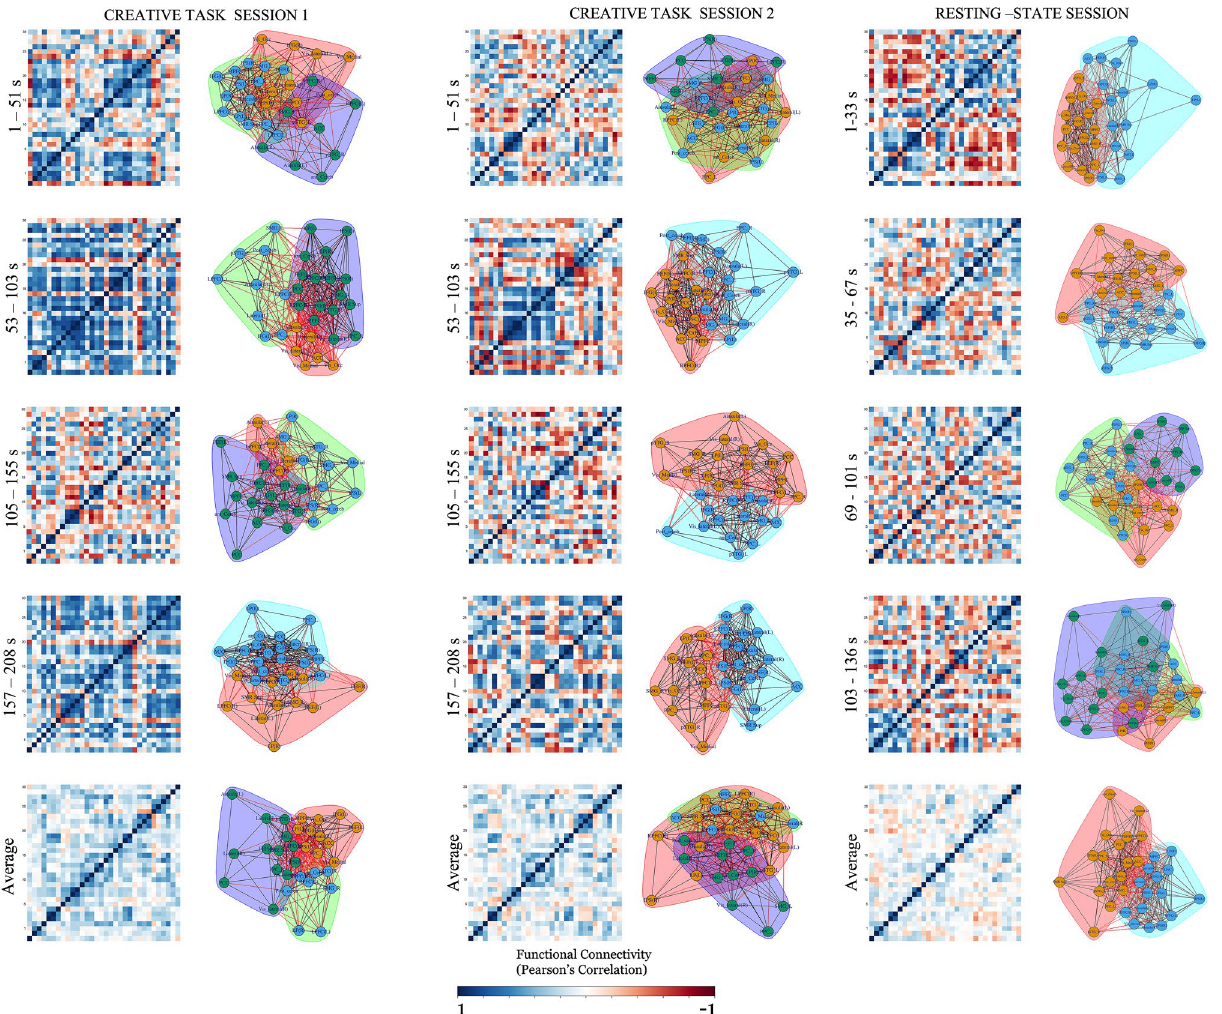
Figure 3. Region-specific changes across time using sliding-window approach (window size = 44 s) for creative task session 1, creative task session 2 and resting-state session. The first column in each session indicates the single windowed correlation map between these times. The bottom row indicates the average of all the first four rows across all the sessions. Second column in every session indicates the graph representation and community detection formed using the fast-greedy algorithm community detection. Each colour indicates community formation for every session, averaged and every windowed correlation map. Node Label List: mPFC medial pre- frontal cortex, LP_L parietal left (lateral), LP_R parietal right (lateral), PCC posterior cingulate cortex, SMR_L sensorimotor cortex left, SMR_R sensorimotor cortex right, SMR_Superior sensorimotor cortex (superior), Visual_Medial visual cortex (medial), Visual_Occipital visual cortex (occipital), Visual_lateral_L visual cortex left (lateral), Visual_lateral_R visual cortex right (lateral), ACC Anterior cingulate cortex, AInsula_L anterior Insula left, AInsula_R anterior Insula right, rPFC_L pre-frontal cortex left (rostral), rPFC_R pre-frontal cortex right (rostral), SMG_L supramarginal gyrus left, SMG_R supramarginal gyrus right, FEF_L frontal eye fields left, FEF_R frontal eye fields right, IPS_L intra-parietal sulcus left, IPS_R intra-parietal sulcus right, LPFC_L pre-frontal cortex left (lateral), PPC_L parietal cortex left (posterior), LPFC_R pre-frontal cortex right (lateral), PPC_R parietal cortex right(posterior), IFG_L inferior frontal gyrus left, IFG_R inferior frontal gyrus right, pSTG_L superior temporal gyrus left, pSTG_R superior temporal gyrus right, Cereb_Ant anterior cerebellum, Cereb_Post posterior gyrus and left superior temporal gyrus. The respective correlation matrices and the networks formed have been depicted in row 2 of Fig. 3 for all the three sessions. For the third averaged window, during the task session 1 (i.e. time 105–155 s), the regions of the DMN showed connections with the bilateral ipsilateral gyrus. The regions of the FPN were strongly connected with the right supramarginal gyrus, right parietal cortex, right inferior frontal gyrus and right superior temporal gyrus. The regions of the cerebellum showed strong connectivity with the left parietal cortex, superior sensorimotor cortex, left posterior parietal cortex and the left superior temporal gyrus. During the task session 2, the DMN showed connectivity with the left parietal cortex, lateral visual cortex, and right prefrontal cortex. The regions of the FPN showed connections with the occipital visual cortex a left prefrontal cortex whereas the regions of the cerebellum